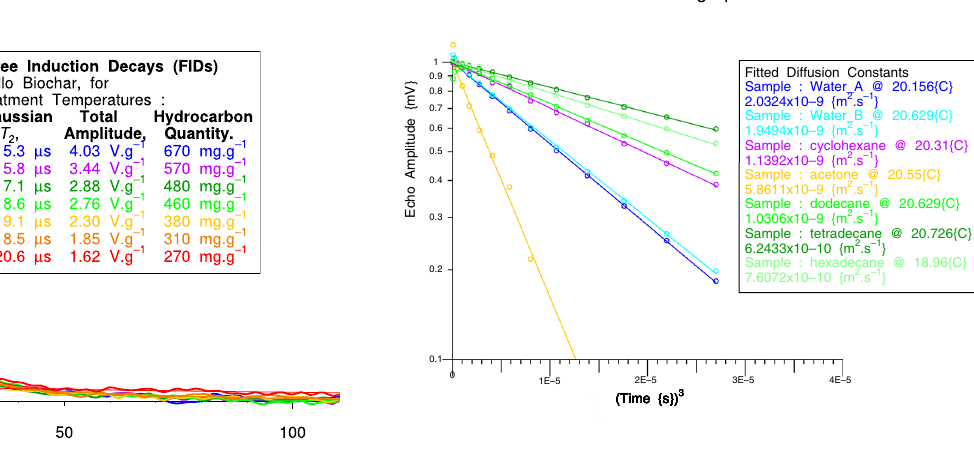
Fig. 17 Normalised liquid self-diffusion vs time 3 , for six mobile liq-